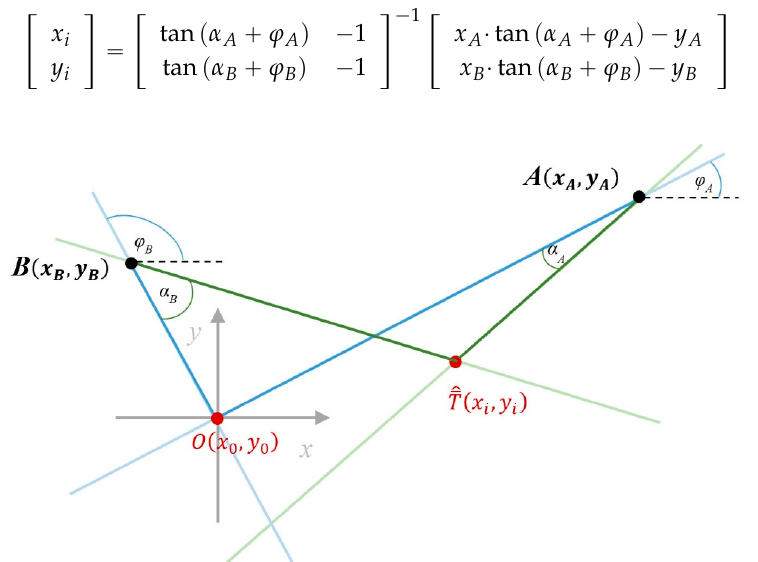
Figure 2. Graphical interpretation of the AoA ranging technique.